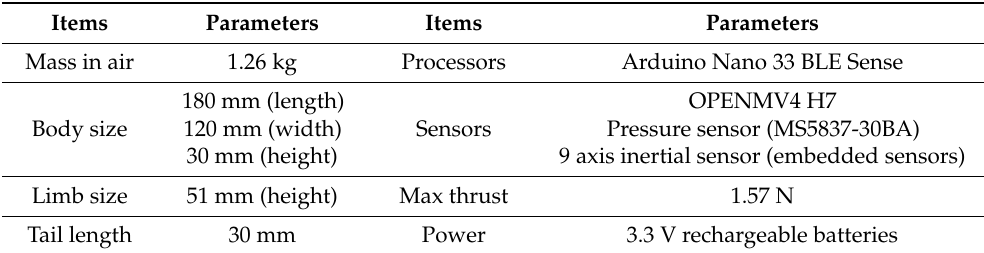
Figure 6. Mechanical design of the bio-inspired son underwater robot: ( a ) design of the son underwater robot; ( b ) illustration of the son underwater robot swimming. Table 2. The technical specification of the son underwater